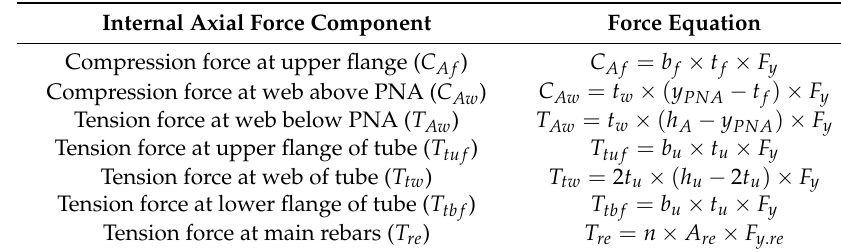
Table 4. Internal force components in case the plastic neutral axis exists at the web.